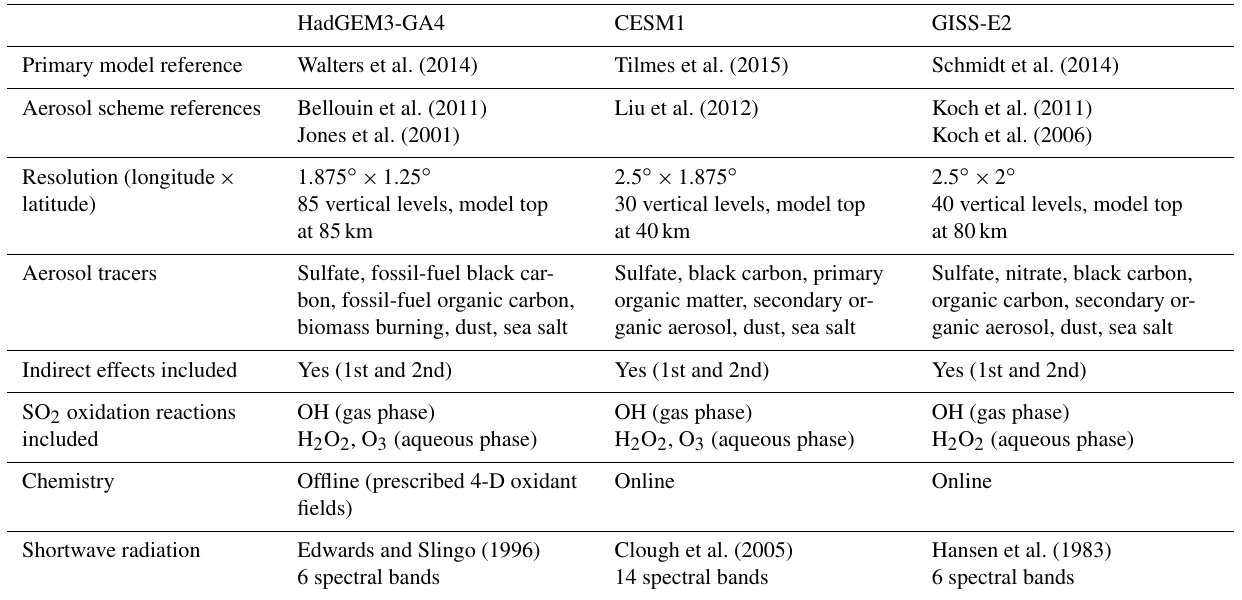
Table 1. Key references and features of the three models and their aerosol schemes used in this study. HadGEM3-GA4 CESM1 GISS-E2